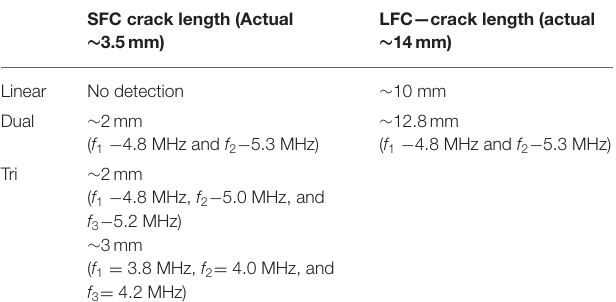
TABLE 3 | Summary of linear, dual, and tri frequency results.